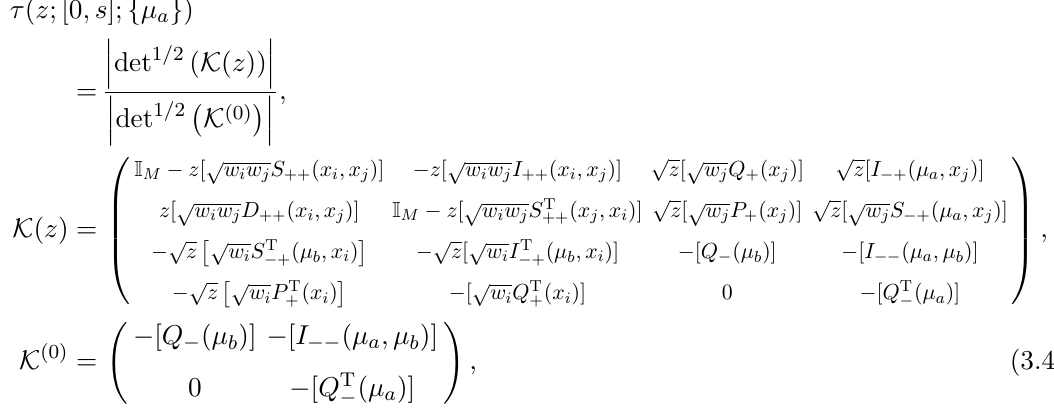
Figure 5 . Scaled mass parameter ( (cid:22) ) dependence of [left panels] cumulative distributions F k ( s ) and [right panels] probability distributions p k ( s ) of the four smallest unfolded eigenvalues k = 1 ; 2 ; 3 ; 4 of the massive chiral GSE with N F = 8 degenerate (cid:13)avors and the topological charge (cid:23) = 0, computed at M = 128. In the upper panels, mass parameters are chosen at (cid:22) = 0 (black, N F = 0 with (cid:23) = 4), 0 : 5 ; (cid:1) (cid:1) (cid:1) (step 0 : 5) ; 10 ; (cid:1) (cid:1) (cid:1) (step 1) ; 20 ; (cid:1) (cid:1) (cid:1) (step 2) ; 30 ; (cid:1) (cid:1) (cid:1) (step 5) ; 60 ; (cid:1) (cid:1) (cid:1) (step 10) ; 100 ; 200 (red to purple), 1 (gray, N F = 0 with (cid:23) = 0). The lower panels are interpolations of the upper ones. N = 2. F